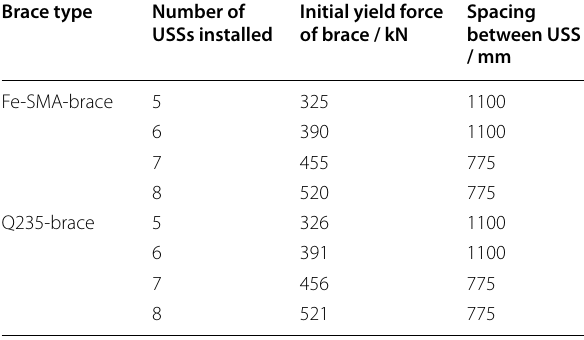
Table 5 Design information of brace